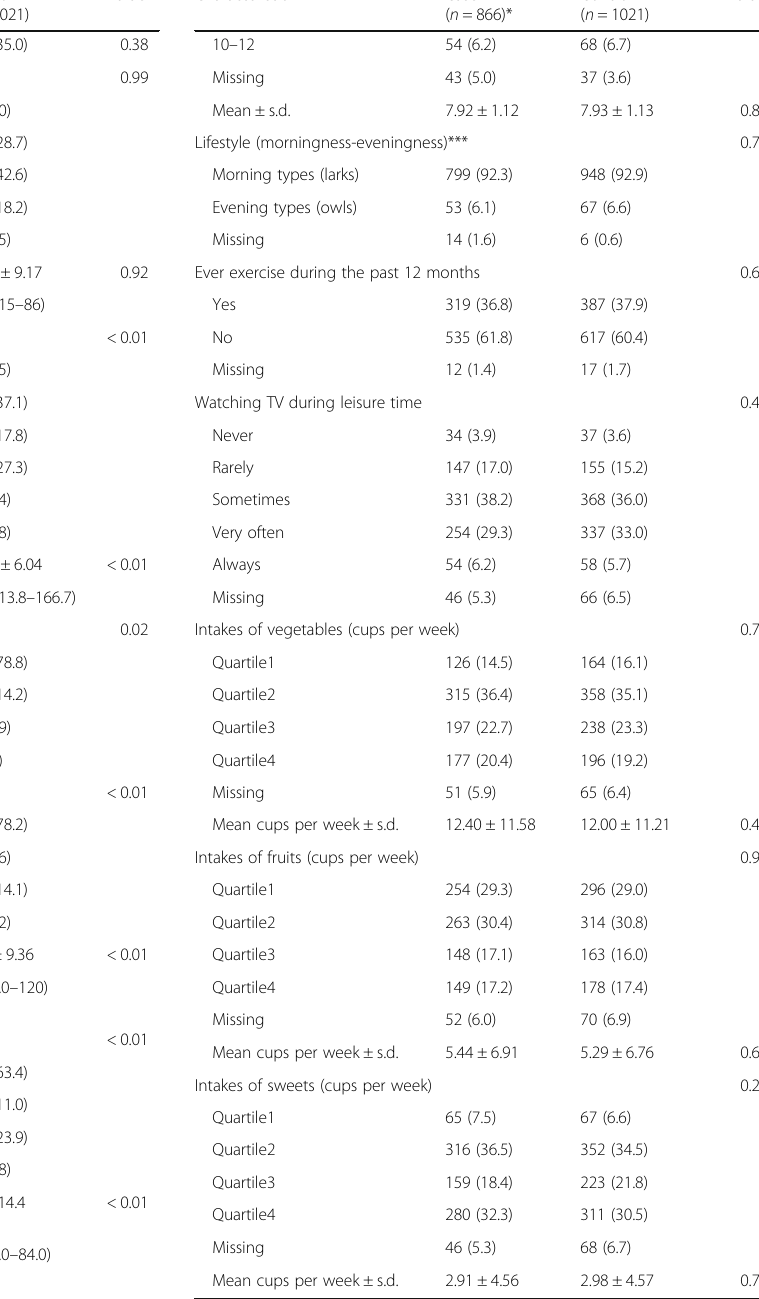
Table 1 General characteristics and variables between case and control groups